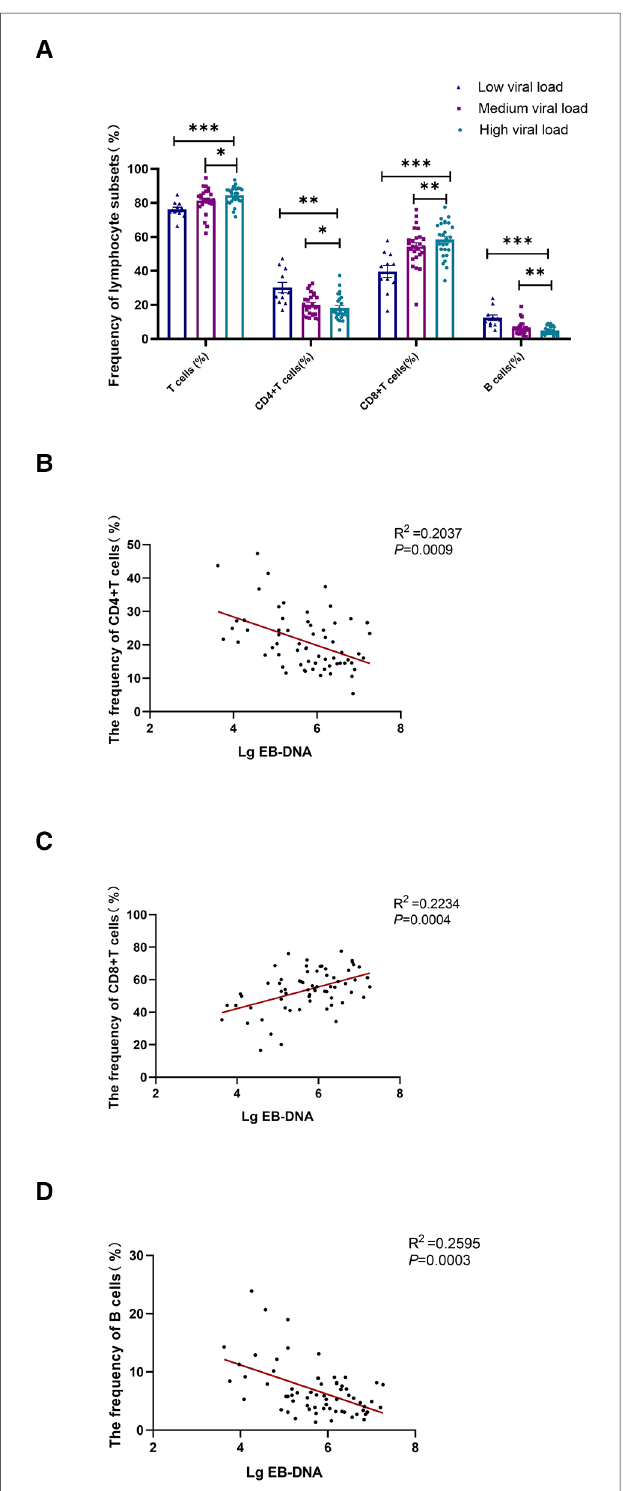
FIGURE 4 Correlational analysis between the EB viral load and the frequency of lymphocyte subsets. Patients with acute IM were categorized into 3 groups based on the EBV viral load. Low viral load represents 2.6< LgEB-DNA<5; medium viral load represents 5 ≤ LgEB-DNA<6; high viral load represents 6 ≤ LgEB-DNA<8. ( A ) The frequency of T cells, CD4 + T cells, CD8 + T cells and B cells in different viral load groups. Correlation between EB viral load and the frequency of CD4 + T cells ( B ), CD8 + T cells ( C ) and B cells ( D ) were displayed. Data are expressed as the means±SD. * P <0.05, ** P <0.01, *** P <0.001.